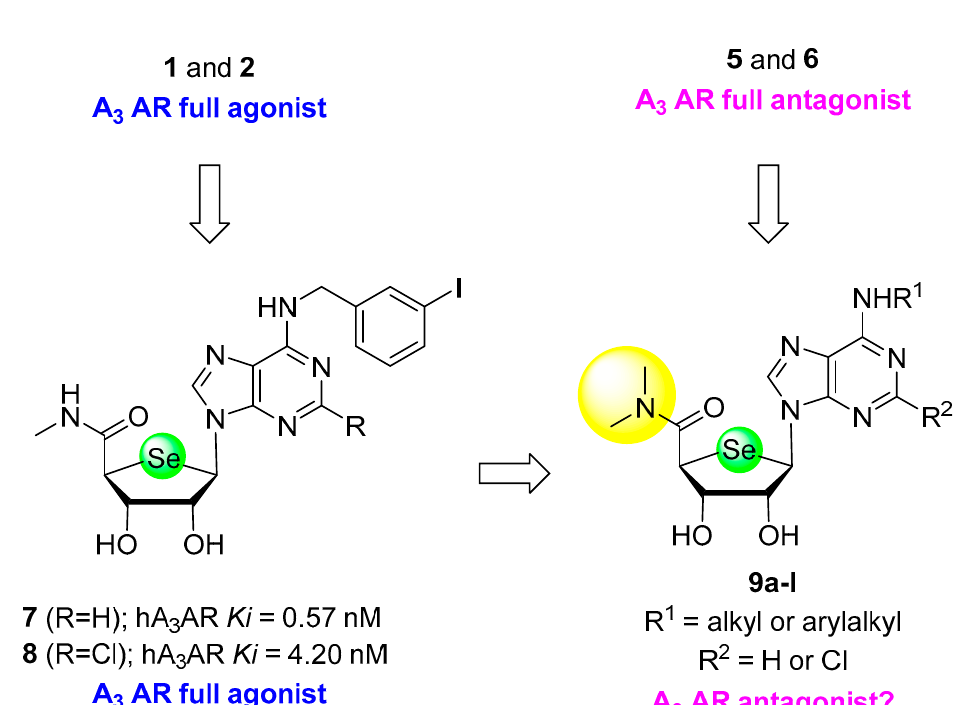
Figure 2. The rationale for the design of the target nucleosides 9a–l .